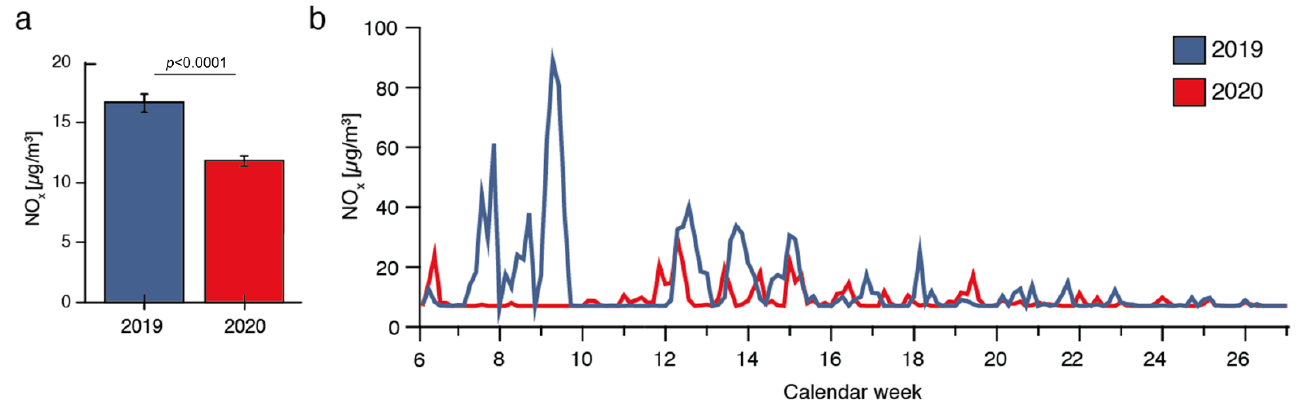
Figure 5. Air pollution within the calendar weeks 6–26 in the years 2019 (blue) and 2020 (red) during the public shutdown, exemplified for NO x of the measuring station within the city of Bonn (data according to the State Agency for Nature, Environment and Consumer Protection of North Rhine Westphalia (LANUV)). Boxplots for mean values ( a ) and distribution of NO x for the weeks 6–26 in the years 2019 (blue) and 2020 (red) ( b ).